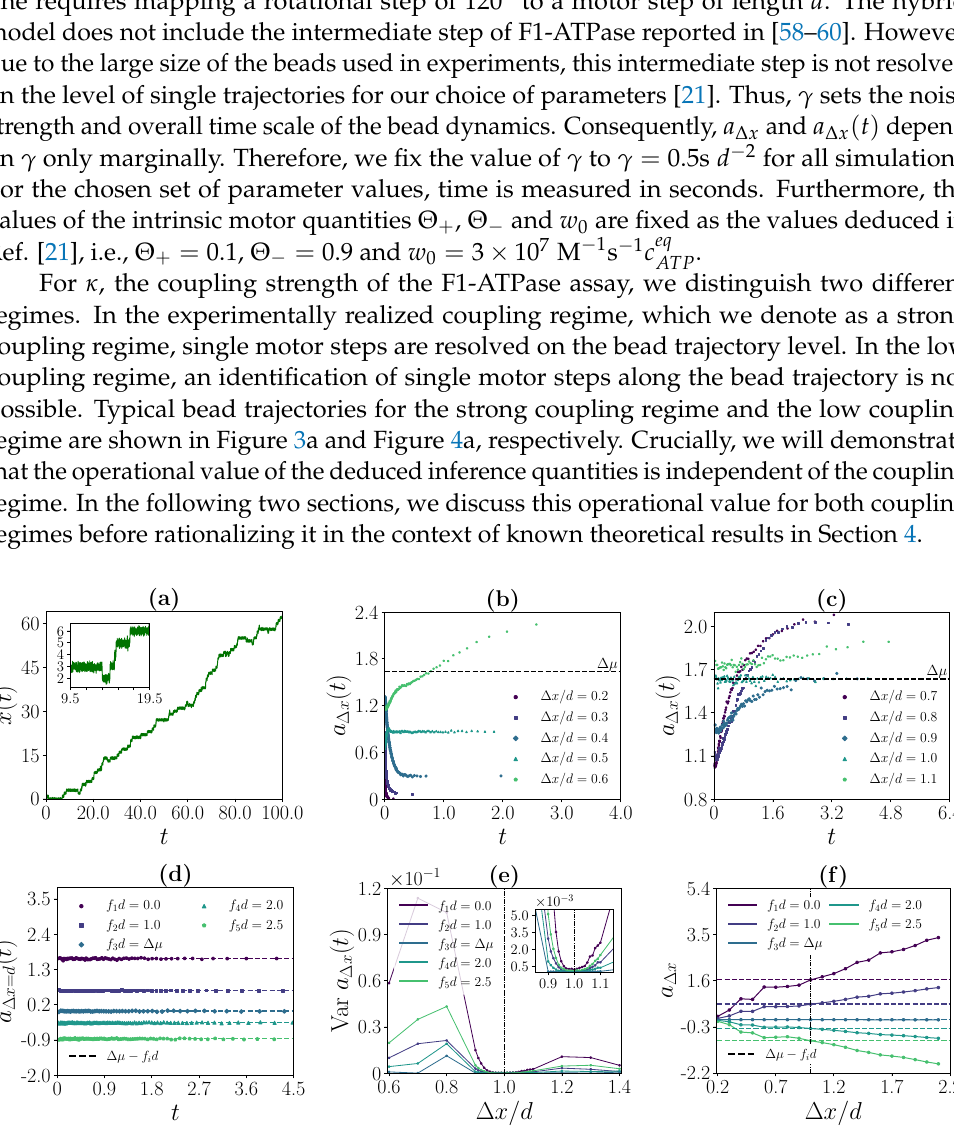
Figure 3. Inference of motor characteristics in the strong coupling regime ( κ = 40 d − 2 , ∆ µ = 1.63). ( a ) Exemplary bead trajectory for fd = 0.0. For the chosen coupling strength, single motor steps can be identified along the trajectory. ( b , c ) a ∆ x ( t ) as a function of t for different ∆ x / d for fd = 0.0. ( d ) a ∆ x ( t ) as a function of t at ∆ x / d = 1.0 for different f . ( e ) Variance of a ∆ x ( t ) as a function of ∆ x / d for different f . ( f ) a ∆ x as a function of ∆ x / d for different f . For ( d – f ), the applied force f 3 is the stalling force of the motor. In ( e , f ), the black dash-dotted line corresponds to ∆ x / d =